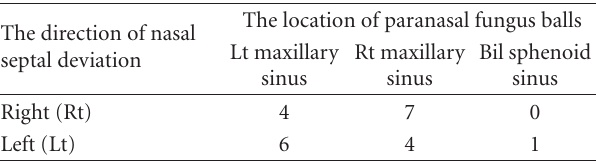
Table 1: The direction of nasal septal deviation and the location of paranasal fungus balls.